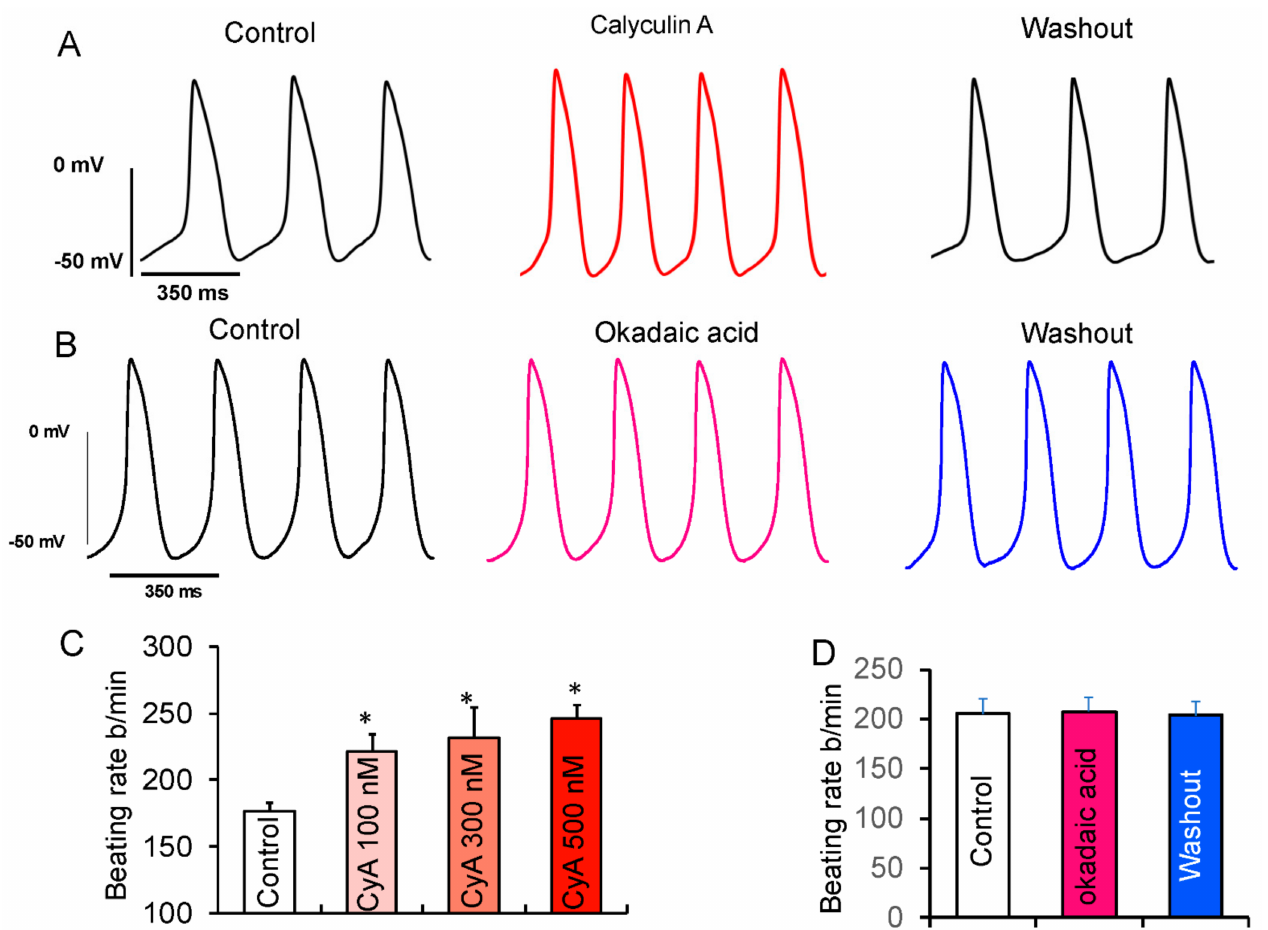
Figure 6. Effects of suppression of PP activity by CyA or OKA on spontaneous beating of isolated rabbit SANC. ( A ) Repre- sentative example of APs recorded in SANC before and during superfusion with 100 nmol/L CyA and following washout of CyA. ( B ) Representative example of SANC APs recorded prior to and during superfusion with 100 nmol/L OKA and after OKA washout. ( C ) The average increase in the spontaneous AP firing rate did not significantly differ in response to 100 ( n = 10), 300 ( n = 5) or 500 nmol/L ( n = 6) of CyA. ( D ) Average spontaneous AP firing rate responses to OKA ( n = 6). * p < 0.05 vs.